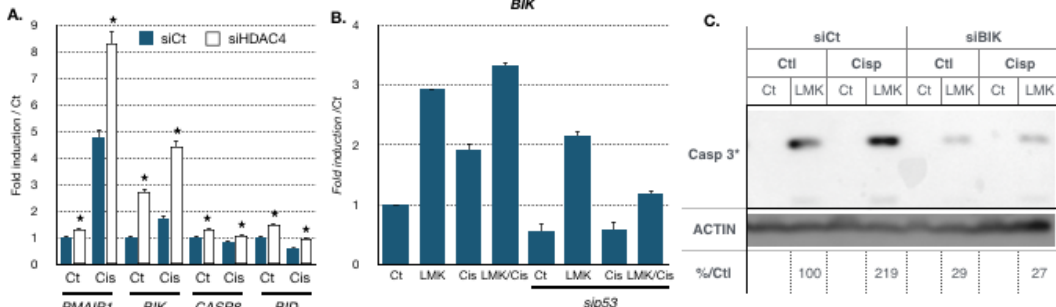
Figure 6. BIK expression is involved in caspase 3 cleavage induced by cisplatin and HDAC4